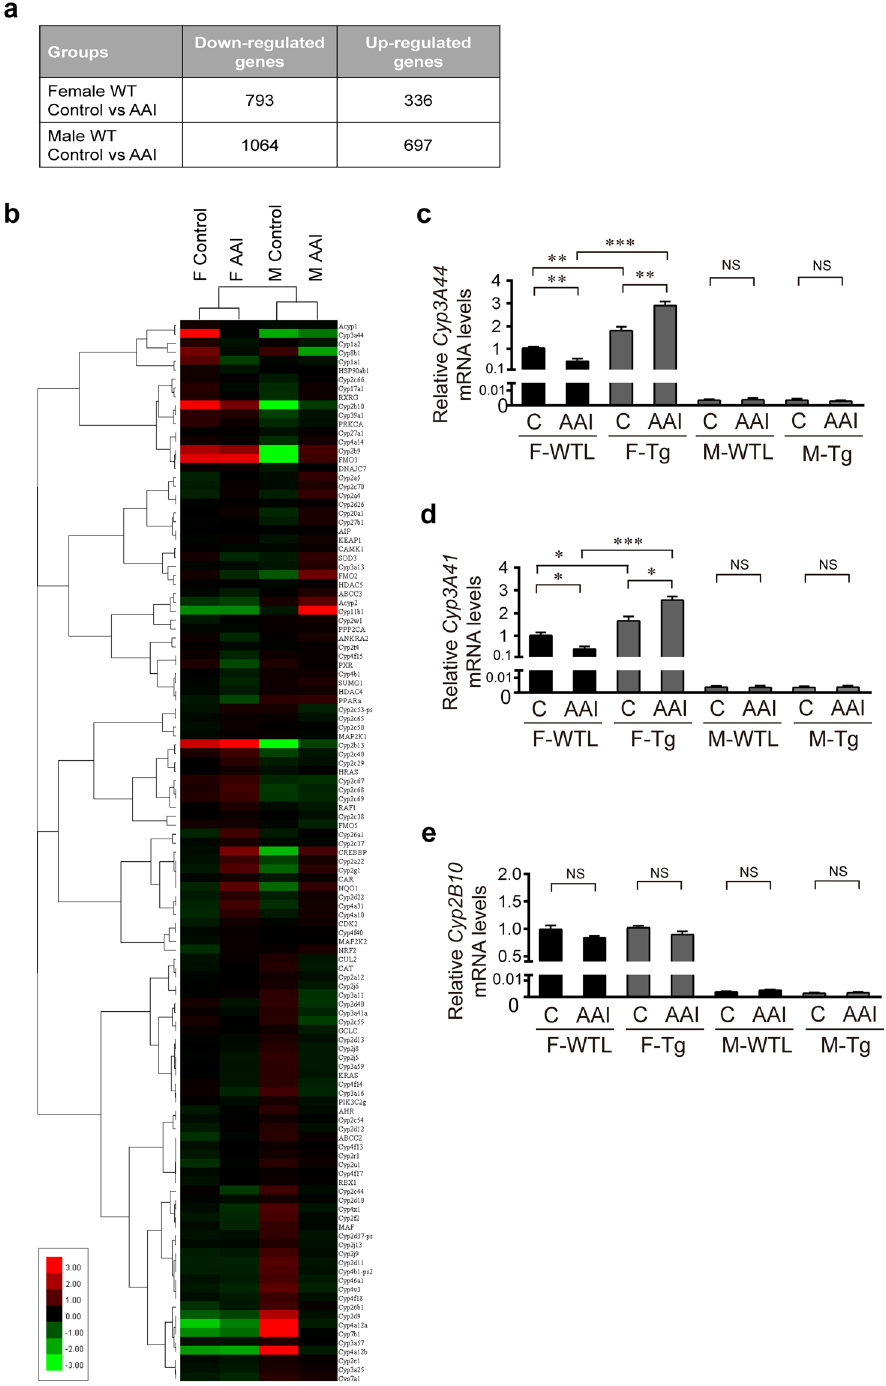
Figure 3. GNMT prevented AAI-induced kidney injury by regulating cytochrome p450 enzymes in female mouse hepatocytes. RNA microarray analysis of the livers from AAI- or corn oil (vehicle control)-treated WT mice, as described in Fig. 1a and c. ( a ) The numbers of signature genes in liver in response to AAI treatment. Genes were identified as significantly changed if the fold change was greater than 2 (up or down) and the p -value was less than 0.01 in comparison to the control group. ( b ) Heat map from hierarchical clustering of xenobiotic metabolism genes. Red and green colors indicate an upregulation and downregulation of gene expression, respectively. Trees on the left of the heat map shows the gene clusters. ( c–e ) mRNA level of Cyp3A44, Cyp3A41 and Cyp2B10 genes in the liver of AAI- or corn oil-treated hGNMT Tg (Tg) and WTL mice, as described in Fig. 2a and b, were determined by qPCR. Data were normalized to β -actin. (C: vehicle control, F: female, M: male). Values are presented as the mean ± SEM, n = 5. p -values were calculated using Student’s t -test. * p < 0.05, ** p < 0.001, *** p ≤